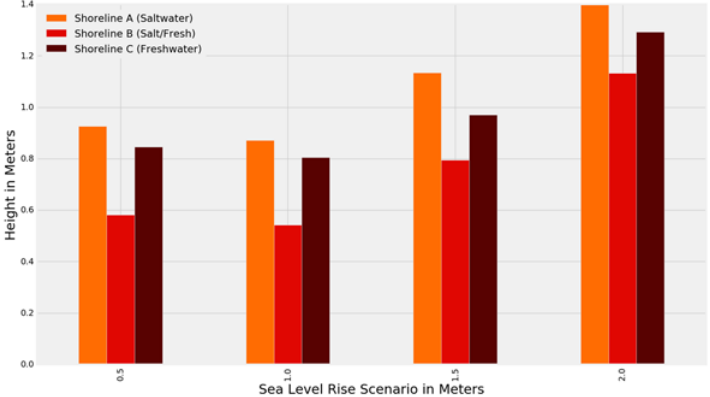
Figure 6. Figure showing the median height of the water that would exceed the height of thousands of line segments that represent the top of the three shorelines—A, B, and C—with sea level rise scenarios between 0.5 and 2 m.